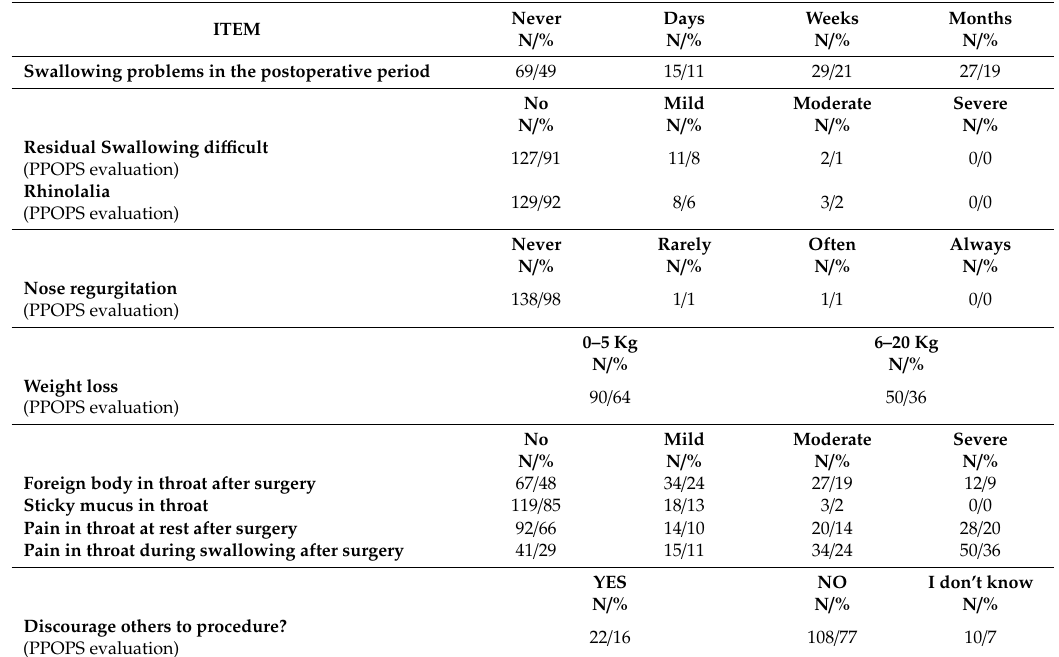
Table 3 summarized all subjective outcomes in the short-term evaluation and long-term follow-up. Table 3. Subjective outcomes in the short-term evaluation and long-term follow-up. ITEM